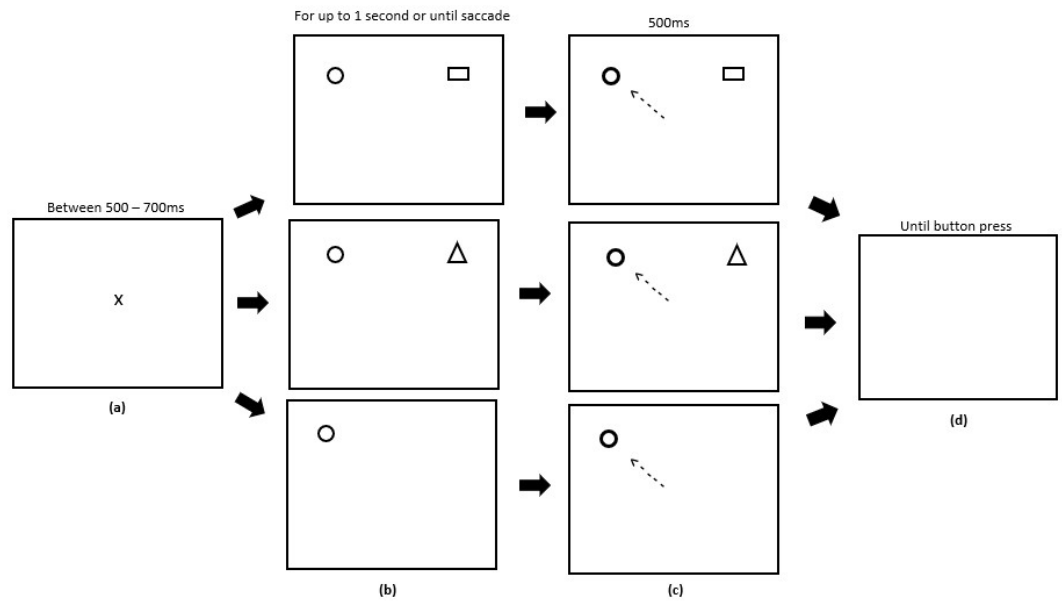
Figure 3. Sequence of events used in the remote distractor (RD) task (not to scale). ( a ) Participants were presented with a fixation cross of a variable time limit between 500–700 ms. ( b ) In a single block, participants could be presented with one of three trials: 1) a known distractor trial (Panel 1), where the distractor (square) used was the same stimuli associated with reward feedback in the reward paradigm; 2) a novel distractor trial (Panel 2), where the distractor (triangle) used was a novel stimulus; 3) a no distractor trial (Panel 3), where the target (circle) was presented on its own with no distractors. These were displayed for up to 1000 ms or until a saccade was made. ( c ) After a successful saccade to the target circle, this target circle would change colour (Panels 1, 2 and 3) and remain on screen for 500 ms. ( d ) Participants were presented with a blank screen, indicating that the trial had ended and they were required to press a button to start the next trial.